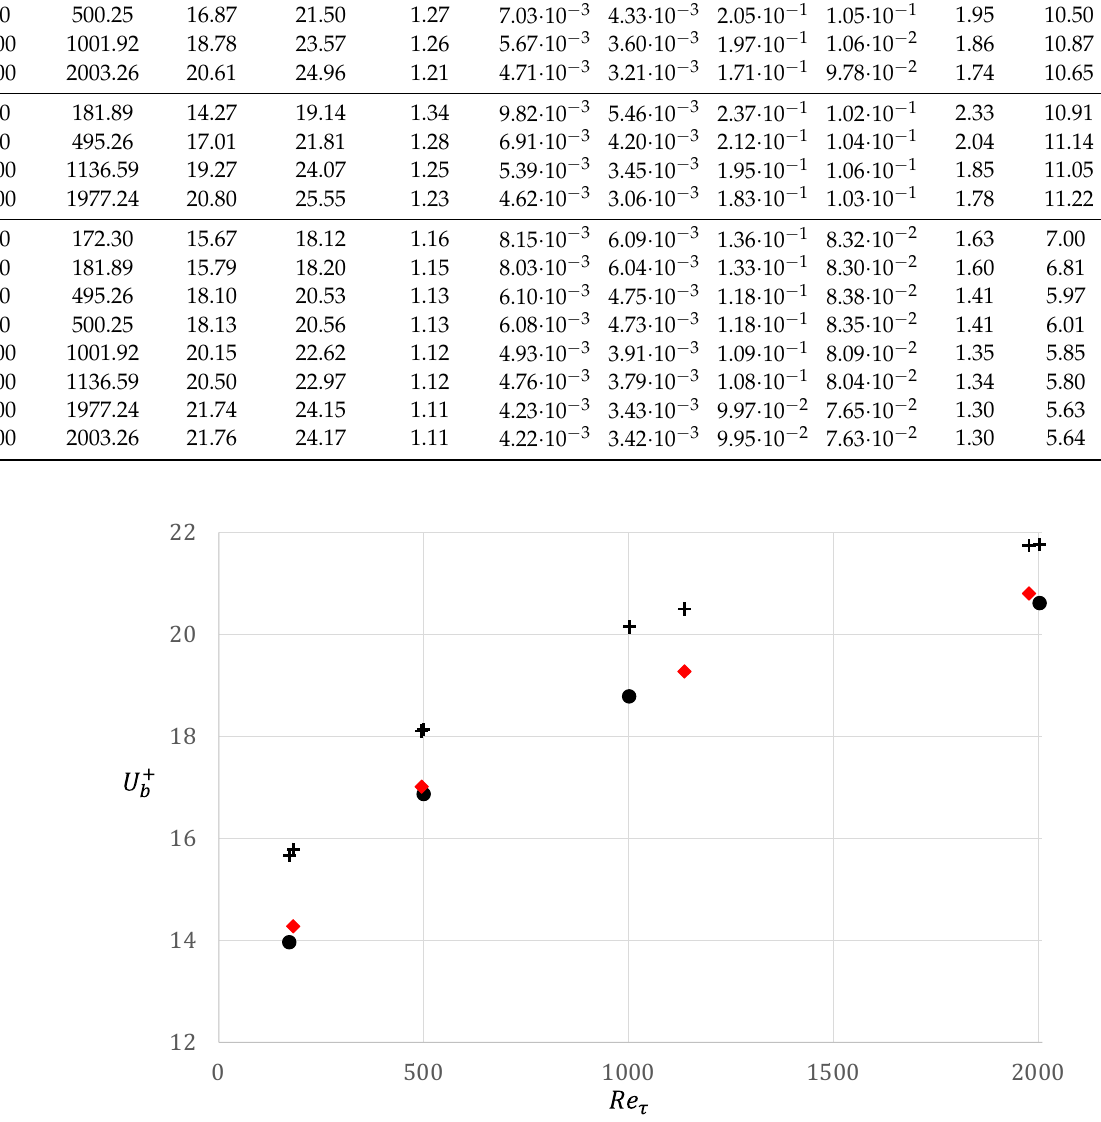
; • pipe DNS data [26]; + 𝑈𝑈 𝑏𝑏